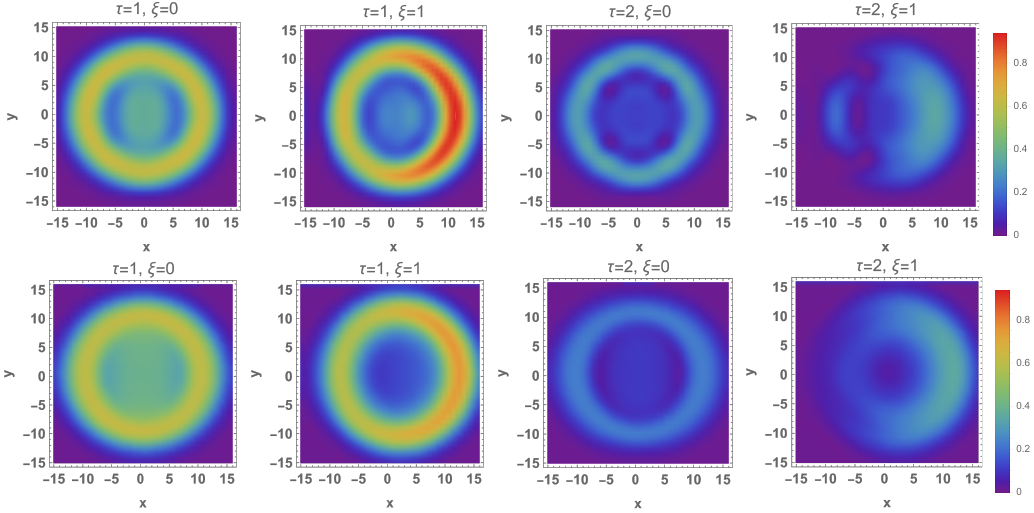
Figure 3 . The residual ∆ (defined in eq. (5.4)) indicating when and where the hydrodynamic approximation is a reasonable description. For ∆ . 0 . 15 hydrodynamics is applicable. We show the results for the zeroth order in transverse derivative approximation (first row) and the exact solutions (second row) from [3], for collisions with otherwise identical parameters. Especially for low rapidities and close to the central region we see quite good agreement between the exact and approximate solution, already at zeroth order in transverse derivatives. In both cases one finds a hydrodynamization time of t ≈ 1 . 25 in the central region and for zero rapidity. Visible artifacts are a consequence of the sparse grids used to discretize the transverse